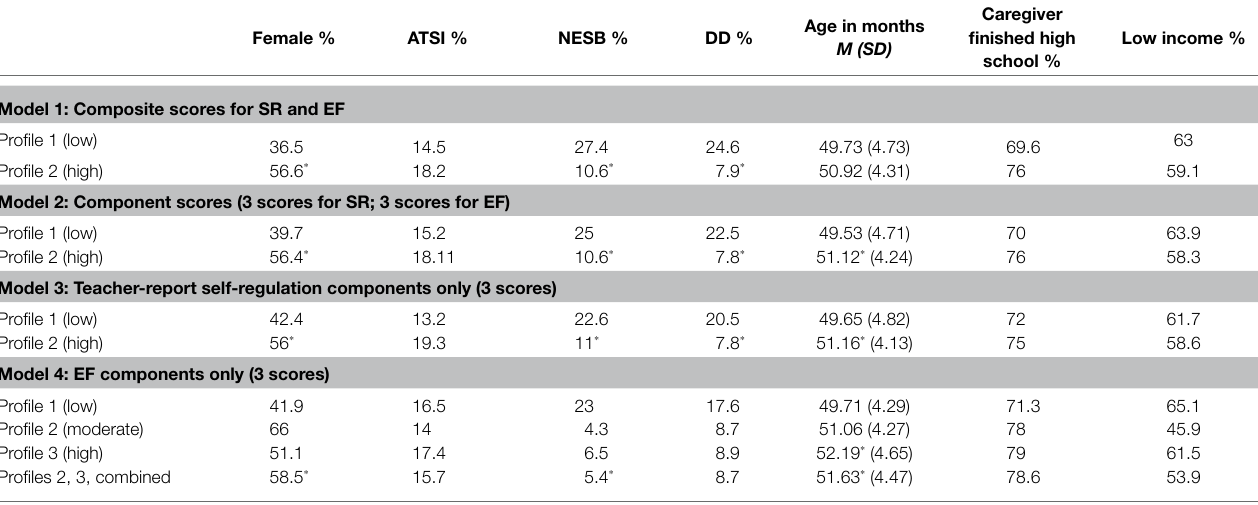
TABLE 4 | Differences across profiles on socio demographics.